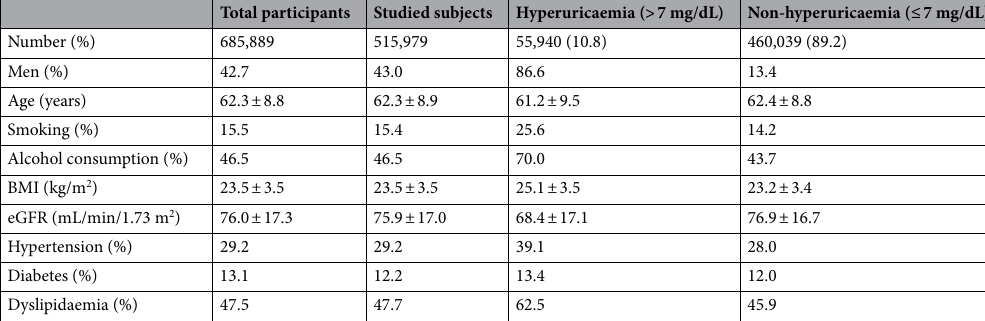
Table 1. Baseline characteristics of the study population. Mean ± standard deviation. BMI body mass index; eGFR estimated glomerular filtration rate.